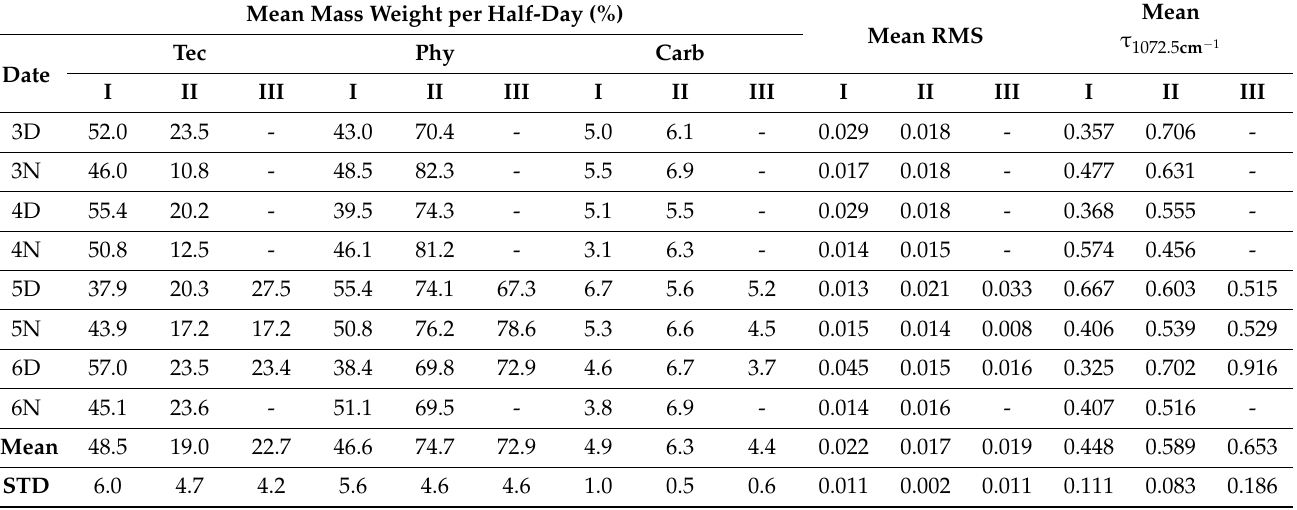
Table 2. Mean mineralogical values and STD of the three dust type sources in the dust storm of May 2017 in East